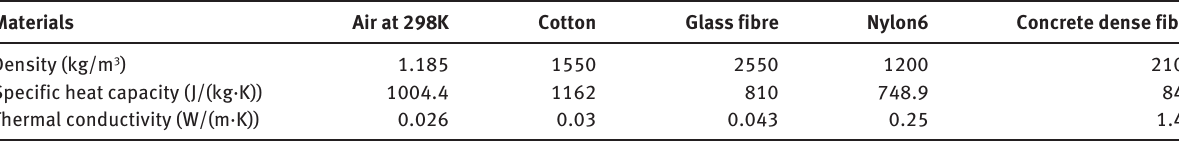
Table 1 Specifications of materials in CFD simulation. Materials